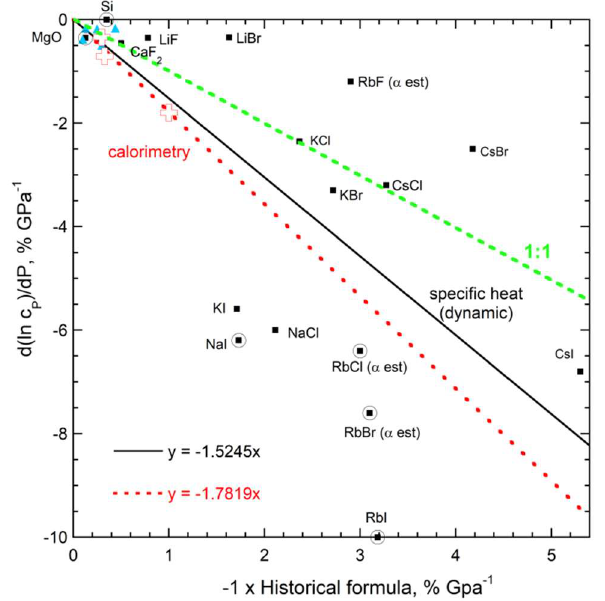
Figure 12. Comparison of the measured P response of specific heat to the thermostatic formula (6), which is peculiarly based on thermal expansivity describing compression. The difference method (blue triangles) provides a cluster of points, and so was not fit. Red = direct calorimetry measurements. Green dashed line = 1:1 correspondence, for reference. Circles = materials for which storativity was not discernably affected by compression. Open cross = metals, by calorimetry. Black line = fit to the scattered dynamic measurements. Data sources listed in Figure 11.